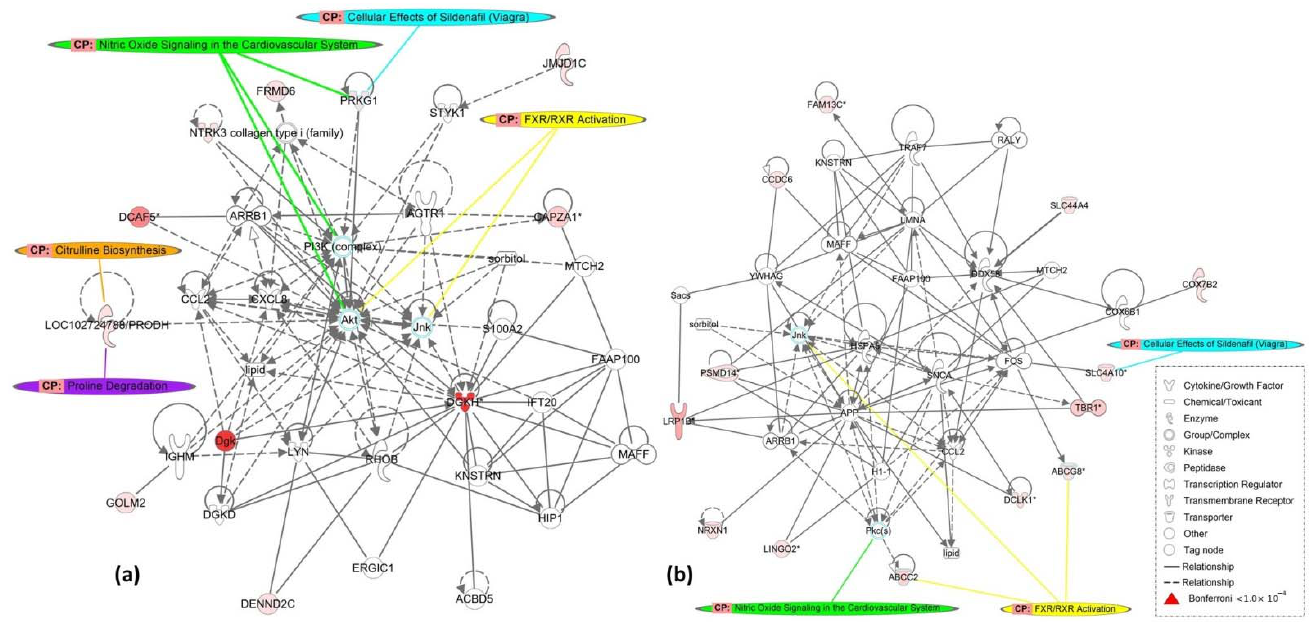
Figure 2. Networks from Ingenuity Pathway Analysis (IPA). ( a ) Network which includes DCAF5 , DGKH , LYN, and the MAPK pathway. ( b ) Network which includes PSMD14 and JNK. Abbreviation : DGKH , diacylglycerol kinase enzyme family; DCAF5 , DDB1, and CUL4 associated factor 5; MAPK, p38 mitogen ‐ activated protein kinases; PI3K, phosphoinositide 3 ‐ kinase. Note: Arrows denote acti ‐ vation/expression. The canonical pathways (CP) illustrated in the networks correspond to the top CPs that the significant SNPs mapped to.